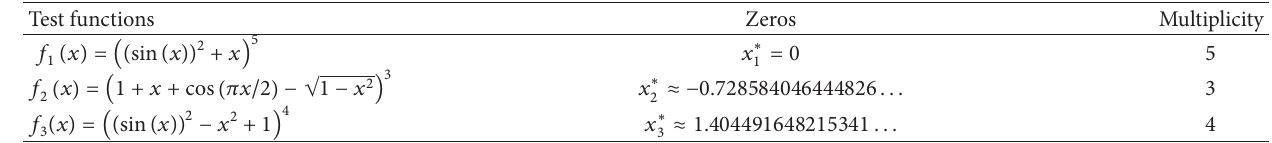
Figure 5: The methods (3) (a) and (5) (b) for Test Problem 3. Table 1: The test functions considered in this paper.